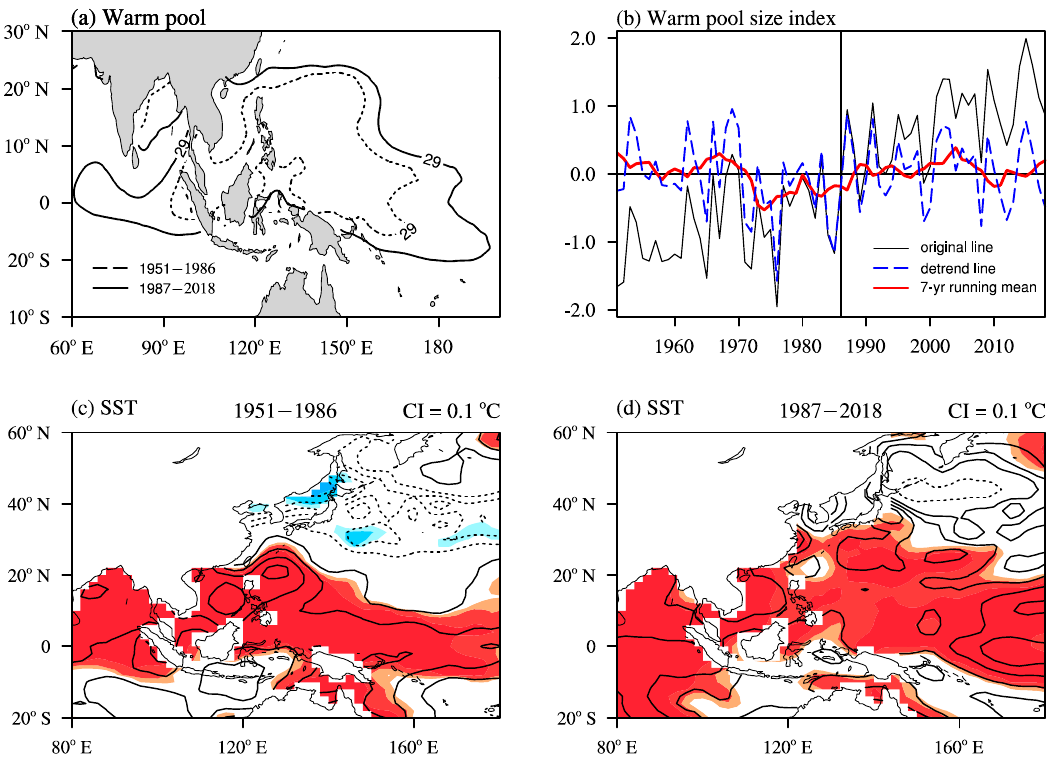
Figure 4. ( a ) Distributions of the JJA 29.0 ◦ C isothermal lines of SST in the Indo-Pacific warm pool (IPWP) during 1951–1986 (dashed line) and 1987–2018 (solid line). ( b ) Time series of the normalized IPWP size index calculated as the region of SST warmer than 29.0 ◦ C divided by the climatological warm pool region in JJA from 1951 to 2018 (black solid curve). The blue dashed curve is the detrended time series, and the red curve is the 9-year running average of the detrended line. ( c , d ) Regression maps of SST (contour; unit: ◦ C) with respect to the normalized IPWP index for 1951–1986 and 1987–2018, respectively. Positive (negative) values are indicated by solid (dashed) contours with the zero contour omitted. The three orange (blue) shadings from shallow to deep in ( c , d ) indicate that positive (negative) anomalies are significant at the 90%, 95%, and 99% confidence levels based on a two-tailed Student’s t test, respectively.